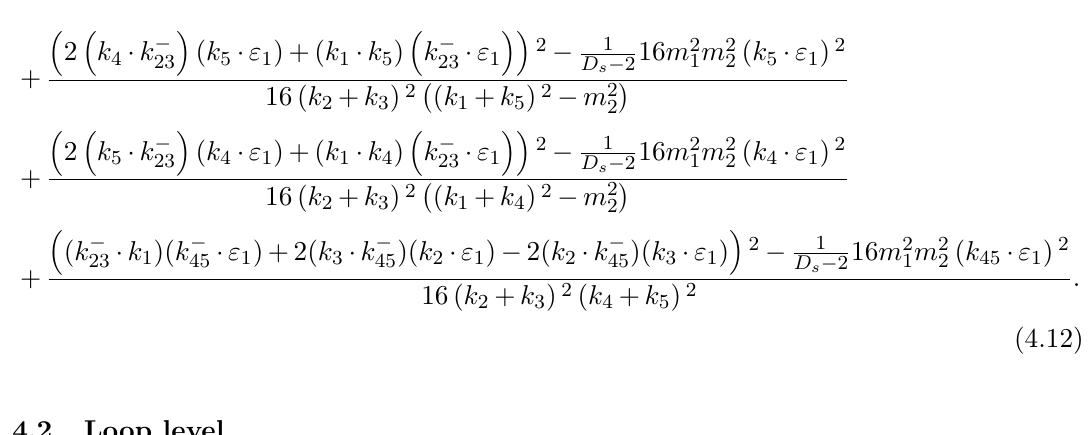
Table 2 . Tree amplitude graphs for two massive scalars, at four and five-point, where k ij = k i + k j and k − = k i − k j . The correction ∆ should be subtracted from the N = 0 supergravity dressing to ij obtain the pure graviton